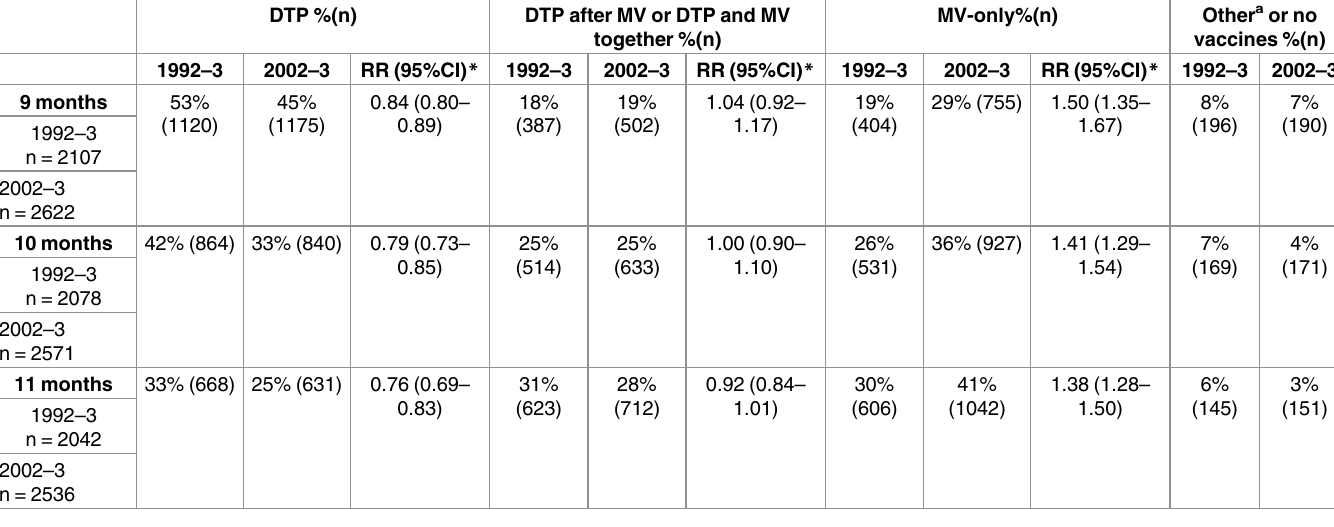
Table 3. Relative risk (RR) of DTP, MV and DTP, MV-only or other/no vaccinesas most recent vaccination by 9, 10 and 11 months of age by